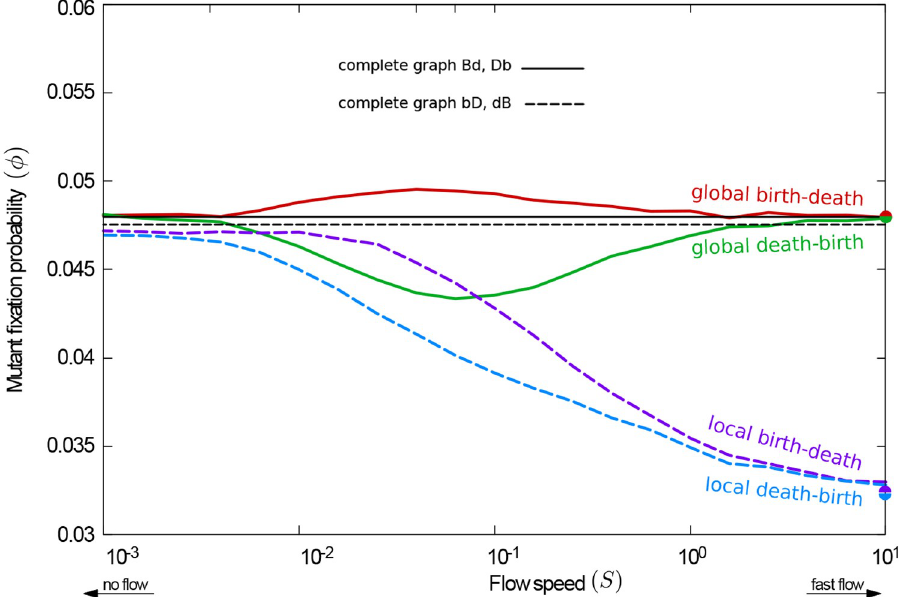
Fig 7. Fixation probability at different flow speeds for simulations started from a square lattice. For the global death-birth process a minimum of fixation probability is found at intermediate flow speeds; conversely, the global birth-death process shows a maximum. For the local processes no extrema are found; instead varying the flow speed interpolates monotonously between the behaviour on fixed lattices and the limit of fast